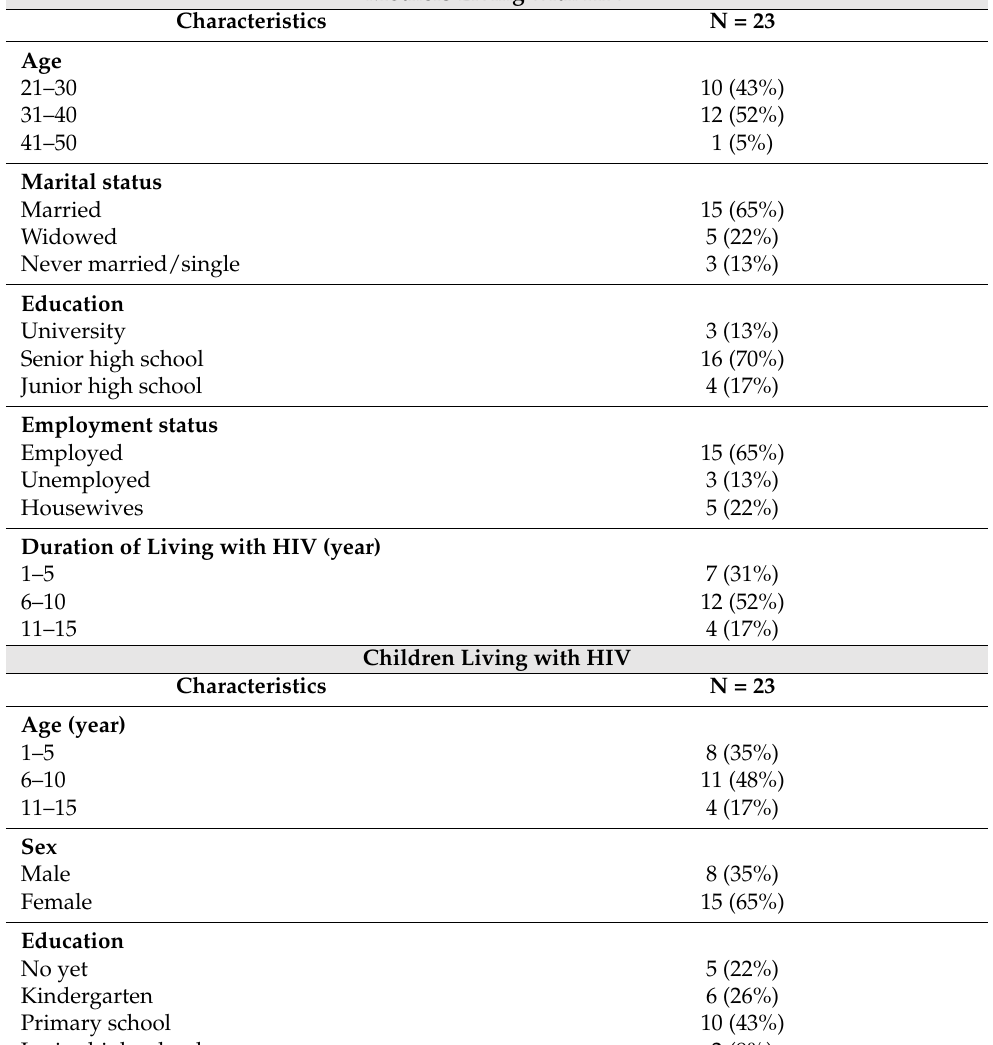
Table 1. Characteristics of